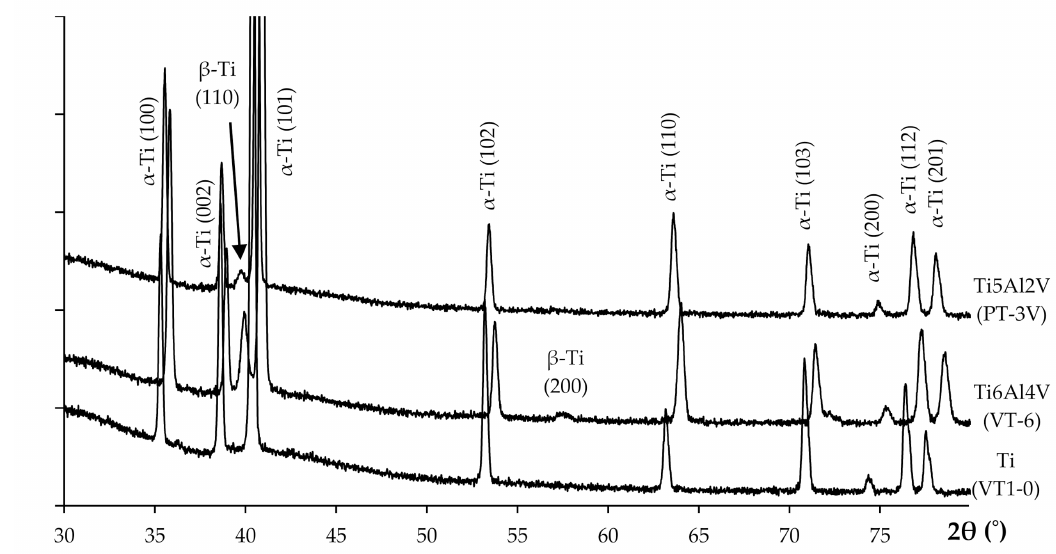
Figure 4. XRD spectra of the sintered Ti